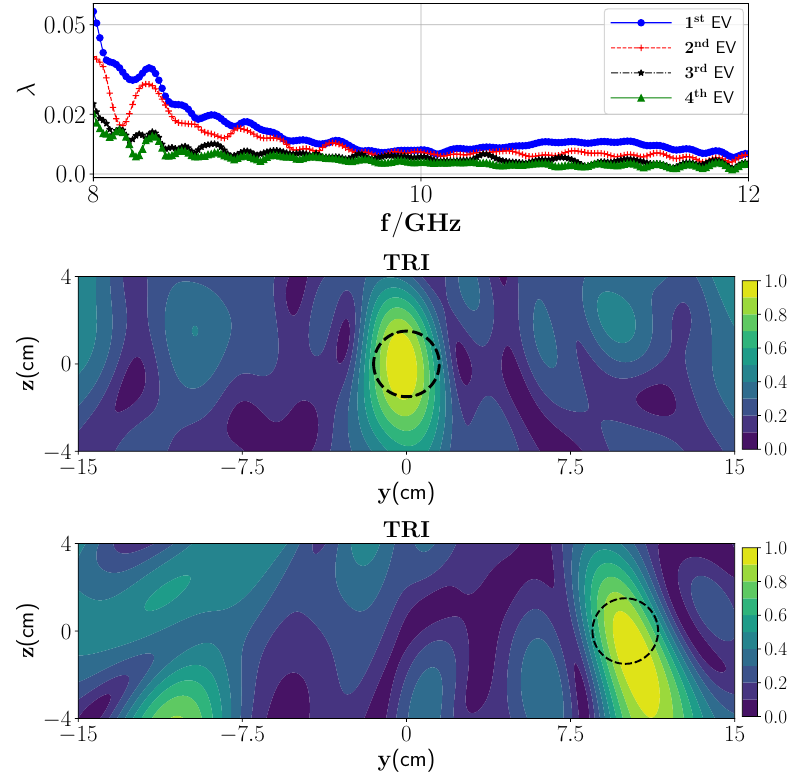
Figure 6. ( Top ) Magnitude of the first four eigenvalues versus the frequencies, ( middle ) reconstruc- tion of the first wet spot moisture case with TRI using first dominant eigenvalue, and ( bottom ) recon- struction of the second wet spot moisture case with TRI-DORT using second dominant